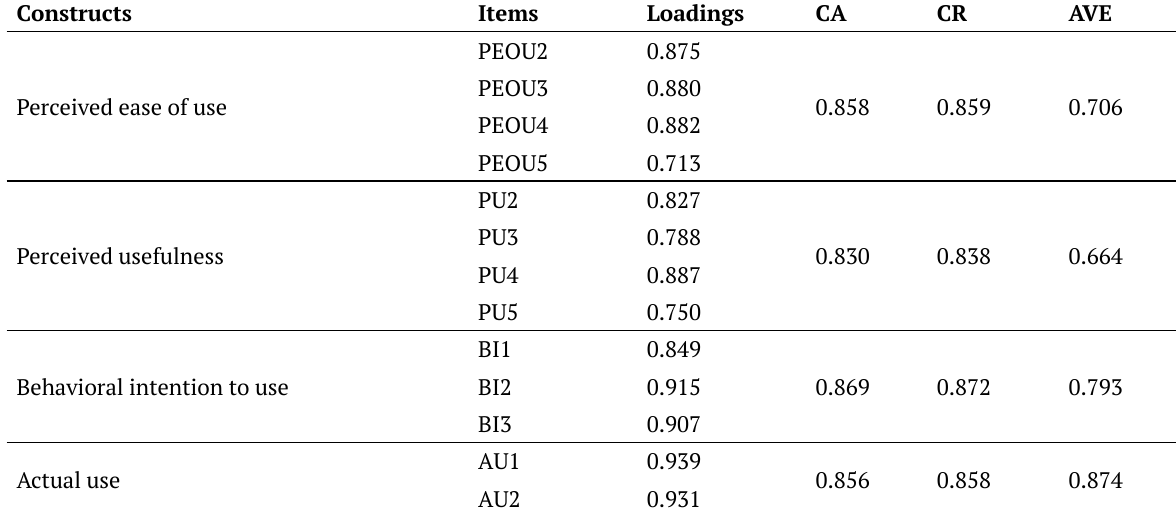
Table 2. Measurement model results